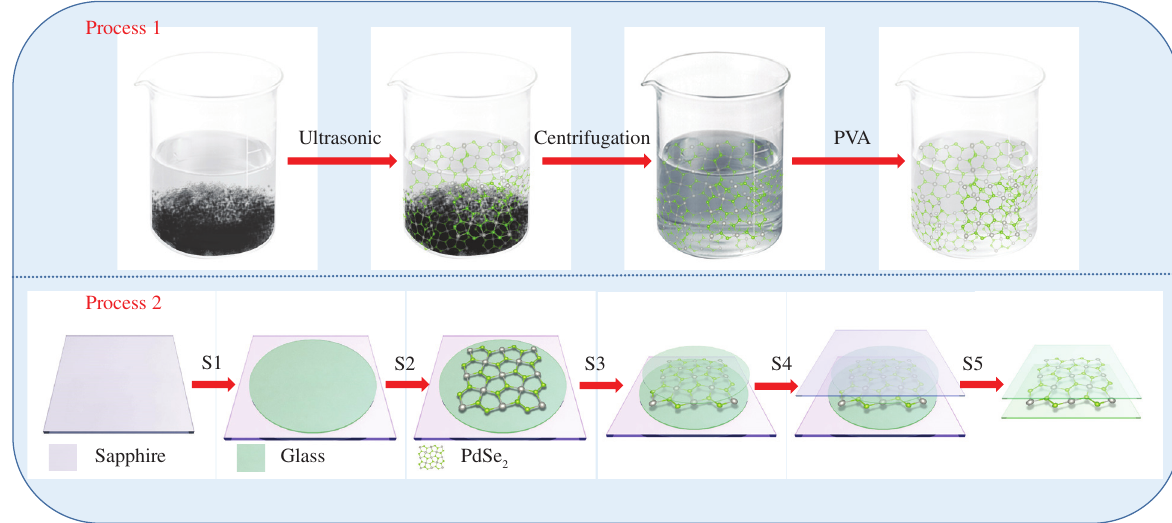
nanosheets and PdSe 2